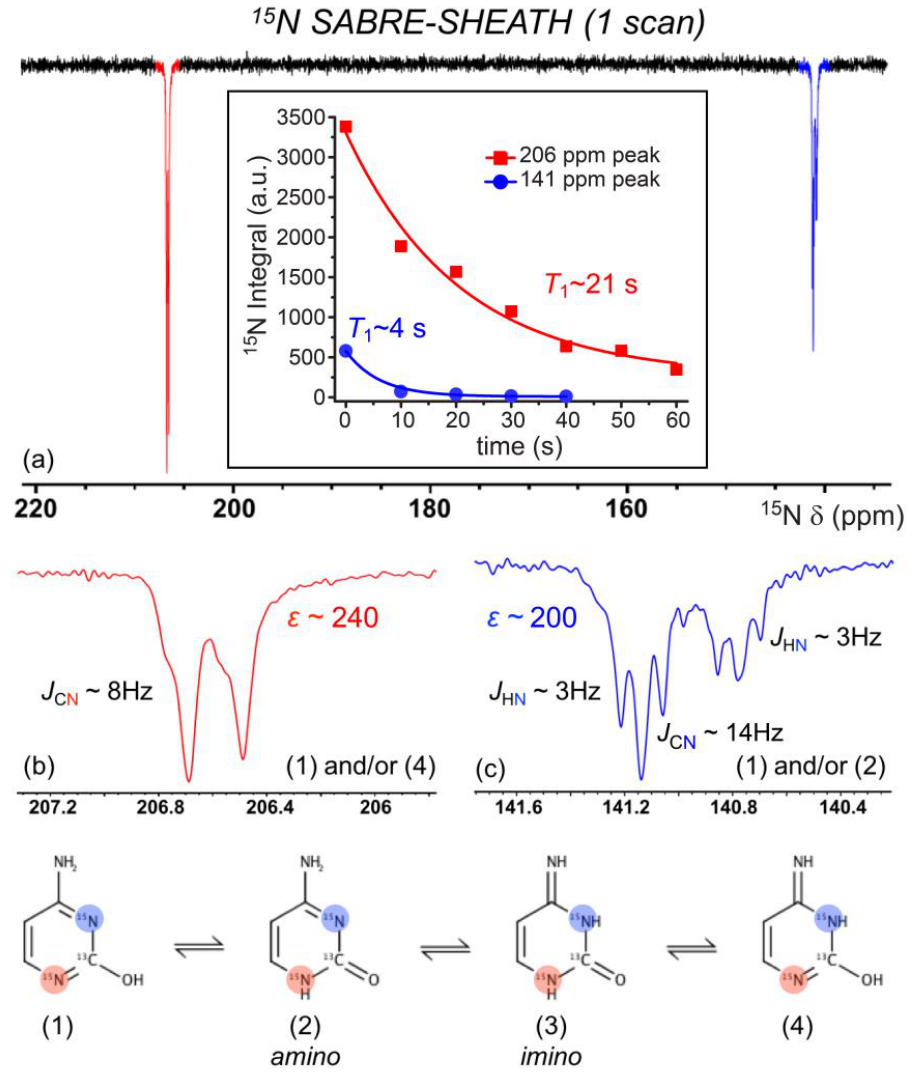
Figure 8. ( a ). 15 N NMR SABRE-SHEATH of doubly-labeled cytosine appears to reveal the preferential binding of tautomers (1), (2), and/or (4) via 15 N A ( b ) over 15 N B ( c ). Steric hindrance from the adjacent ketone and amine to 15 N B likely reduces the binding ability of tautomers (1) and (2). Enhancements calculated from the 8.65 M 15 N 2 -imidazole thermally polarized reference section shown in Figure 7. 15 N spectra here were taken without 1 H decoupling. The inset of ( a ) shows that the N A (206 ppm) and N B (141 ppm) sites decay with different 15 N T 1 values (measured at 9.4 T; each point is a separate experiment with variable delay time at high field prior to acquisition) of 4.3 ± 0.5 s (blue) and 20.6 ± 4.2 s (red).